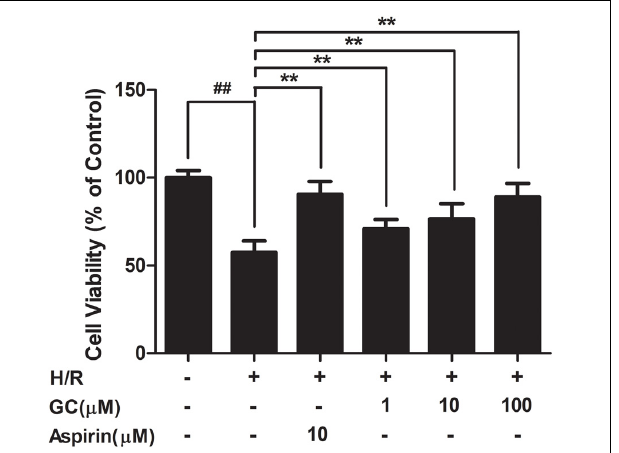
FIGURE 6 | Effects of GC on cell viability after H/R procedure. Data were expressed as mean ± SD ( n = 8). ## P < 0.01 vs. control group; ∗ P < 0.05, ∗∗ P < 0.01 vs. H/R